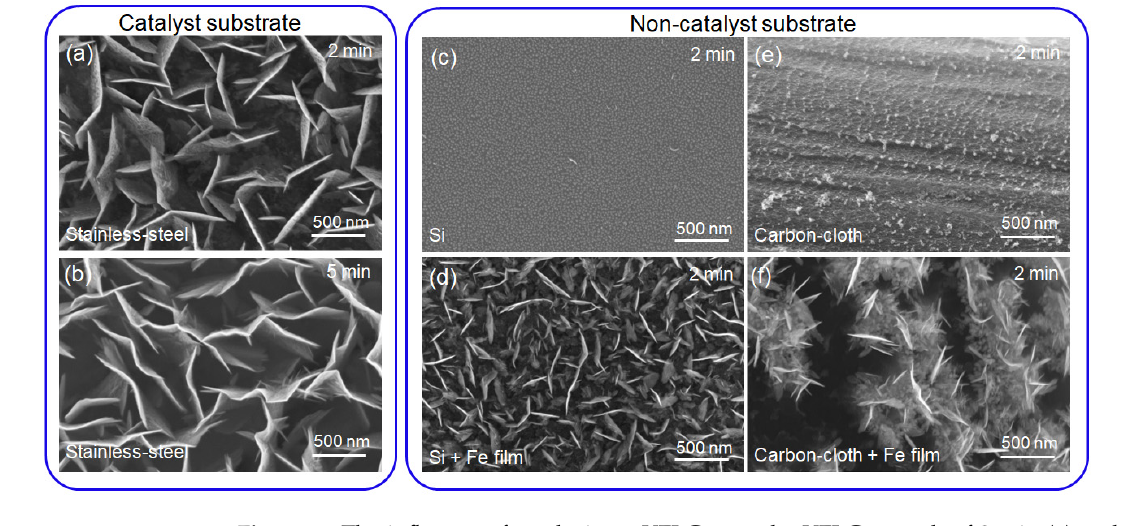
Figure 3. The influence of catalysis on VFLG growth. VFLG growth of 2 min ( a ) and 5 min ( b ) on stainless-steel substrates with pretreatment. VFLG growth of 2 min on ( c ) Si, ( d ) Si + Fe film, ( e ) flexible carbon-cloth and ( f ) flexible carbon-cloth + Fe film substrates with pretreatment. Table 1. The vertical few-layer graphene (VFLG) growth on four substrates with the influence factors of contact angle, pretreatment and catalysis.